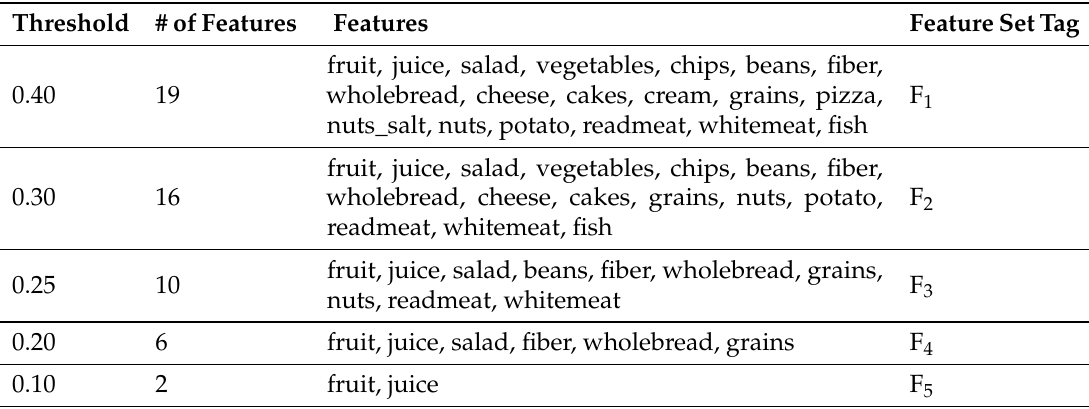
Table 3. List of features above different